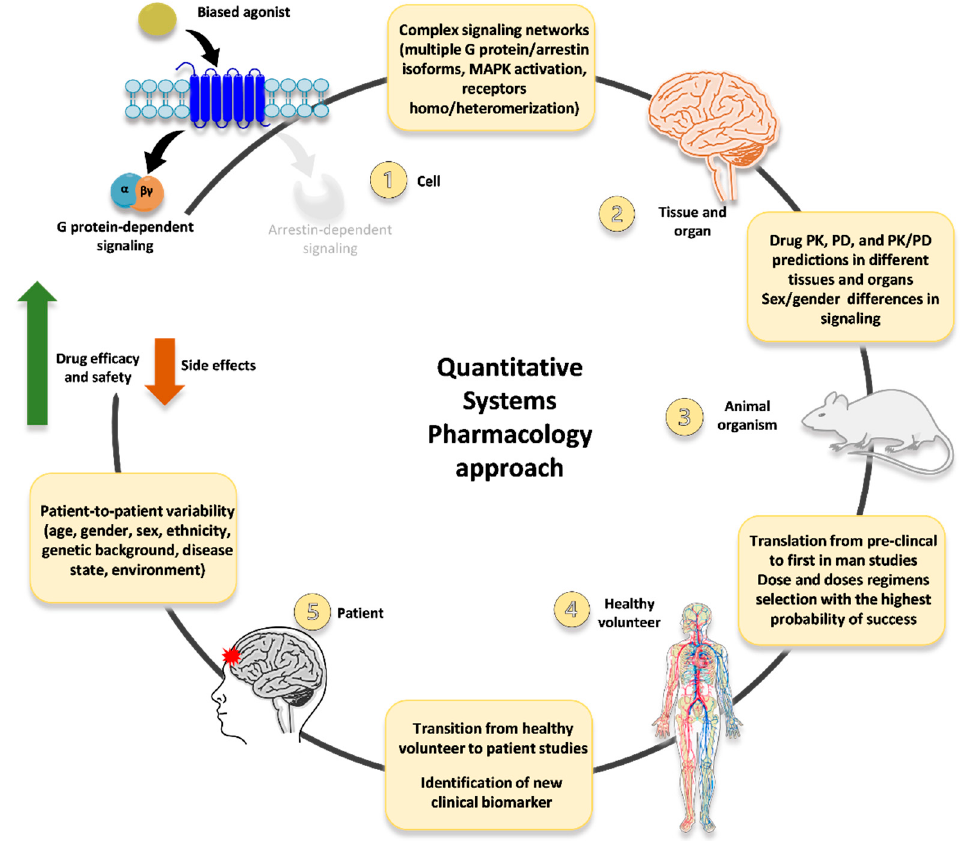
Figure 2. An innovative QSP-based approach for G protein-biased opioid agonists development.